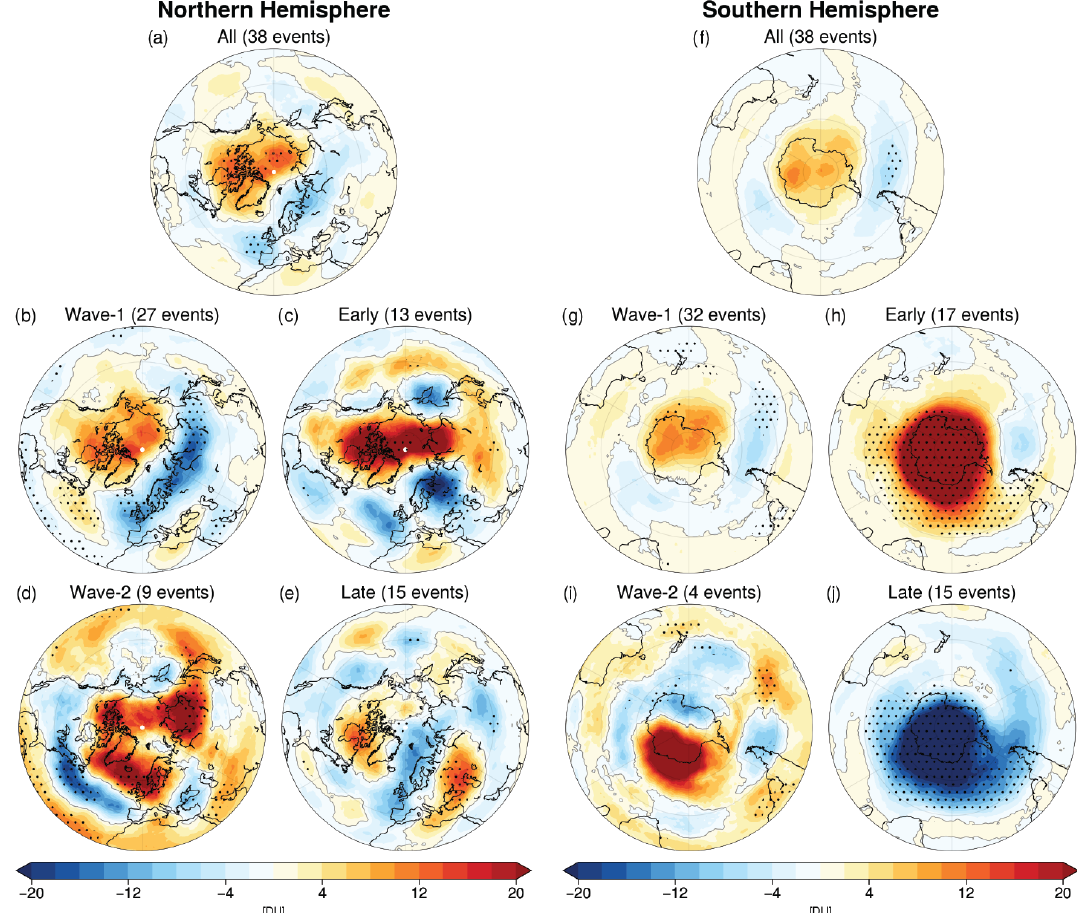
Figure A1. Composite total column ozone anomaly (Dobson units) averaged over the 10d prior to FSWs at 50hPa for (a–e) the NH and (f–j) the SH. Panels show the composites based on (a, f) all events from 1979–2016 (the period of the TCO dataset), (b, g) wave-1 or (d, i) wave-2 classification, or (c, h) early or (e, j) late classification. Stippling in (a, f) indicates regions where the anomaly composites are significantly different from zero at the 95% confidence level on a two-tailed t test; stippling in other panels shows where composites are significantly different from each other (e.g., wave-1 vs. wave-2, early vs. late) using a t test for two samples of unequal